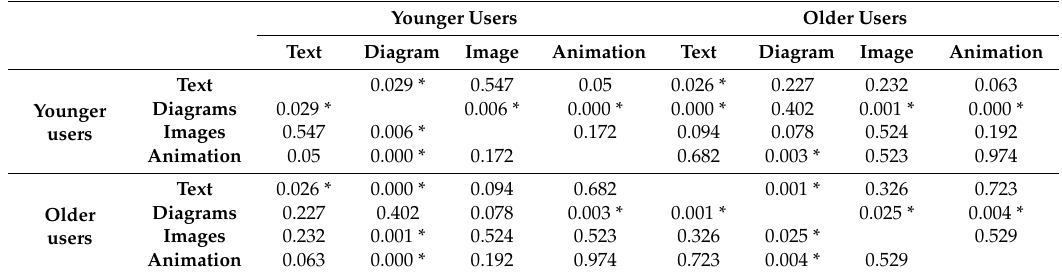
Table 18. Post-hoc comparison of younger and older users’ SUS results.